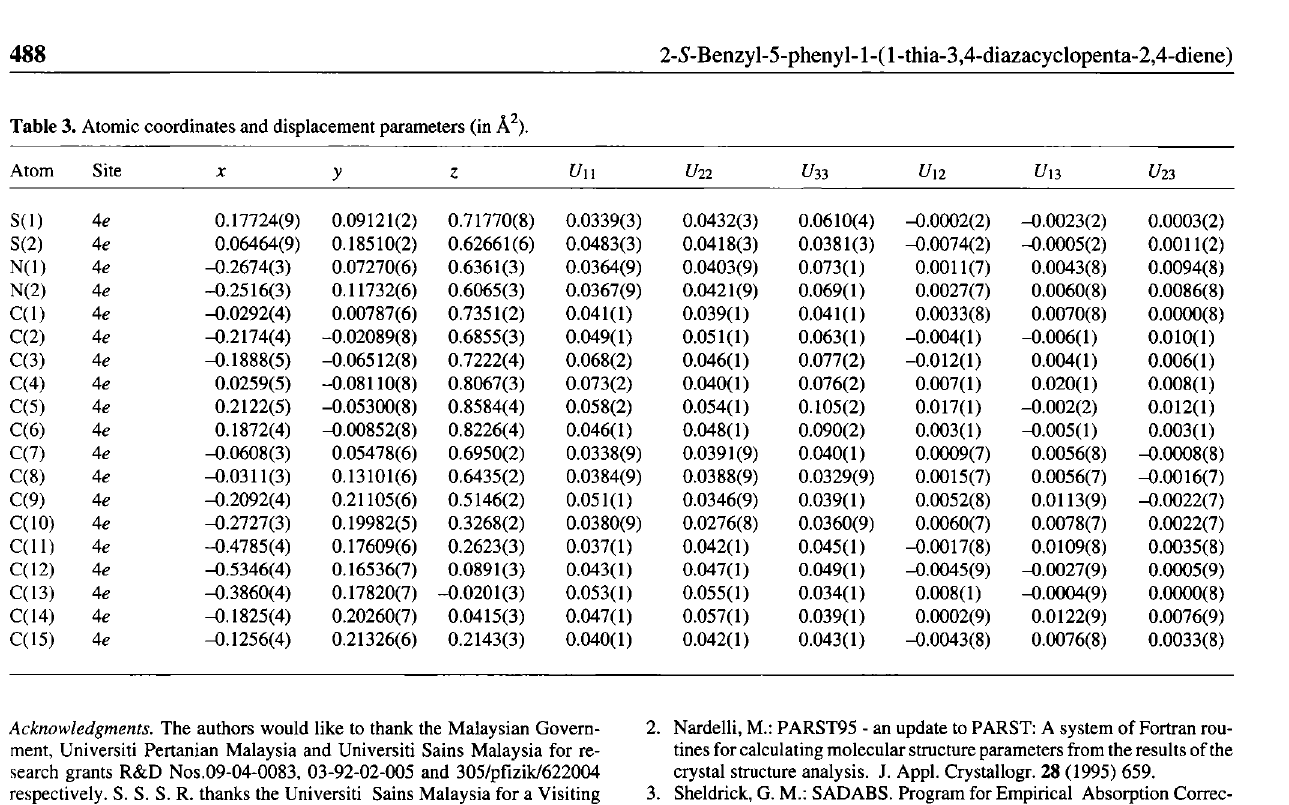
Table 3. Atomic coordinates and displacement parameters (in Â 2